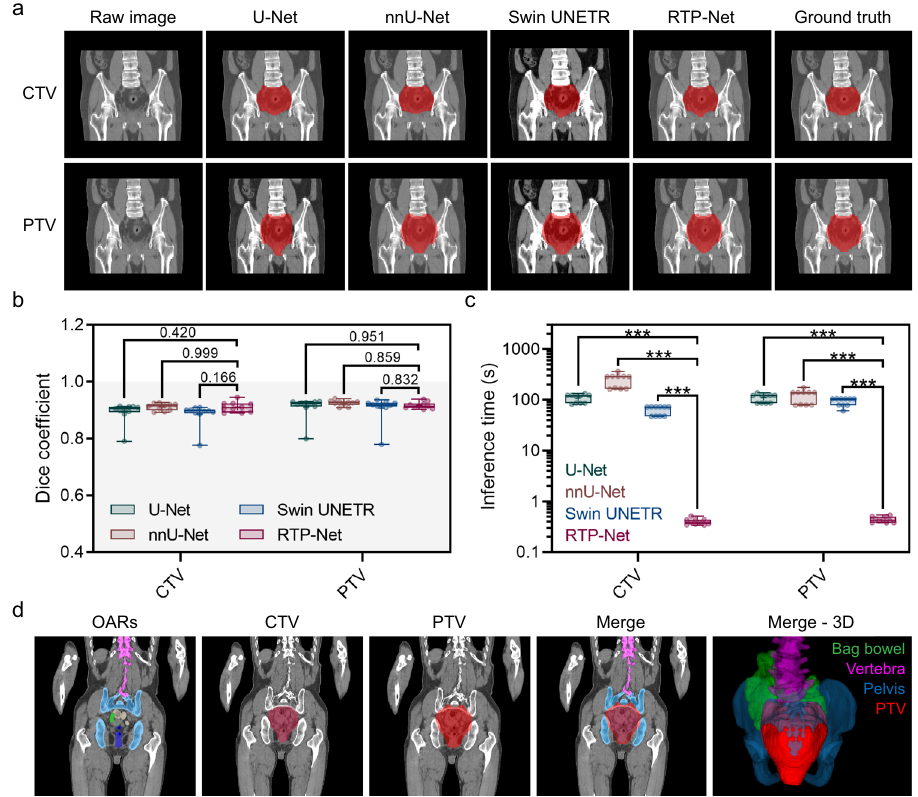
Fig. 7 | The performance of target volume delineation by the proposed RTP- Net, compared with U-Net, nnU-Net, and Swin UNETR. a Delineation results of theclinicaltargetvolume(CTV)andplanningtargetvolume(PTV)bytheproposed RTP-Net, U-Net, nnU-Net, and Swin UNETR, labeled by red color. ( b ) Dice coef fi - cientsand( c )inferencetimesoffourmethodsintargetvolumedelineation,shown in box-and-whiskerplots.The fi rst quartileformsthe bottomand the thirdquartile forms the top of the box, in which the line and the plus sign represent the median andthemeanvalues,respectively.Thewhiskersrangefromminimumtomaximum showing all points. Statistical analyses in ( b ) and ( c ) are performed using two-way